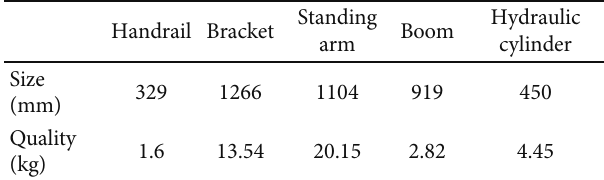
Figure 2: Flow chart of patient transfer device dynamics modeling. Table 1: Equivalent connection of patient transfer device dynamics model.